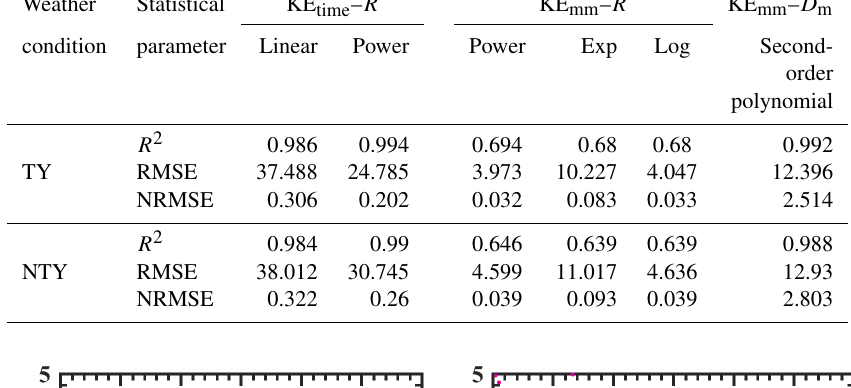
Table 3. Statistical parameters (correlation coefficient – R 2 ; root mean square error – RMSE; normalized RMSE – NRMSE) for ty- phoon (TY) and non-typhoon (NTY) rainy days. Note that the units for RMSE are Jm − 2 h − 1 for KE time – R relations and Jm − 2 mm − 1 for KE mm – R and KE mm – D m relations.